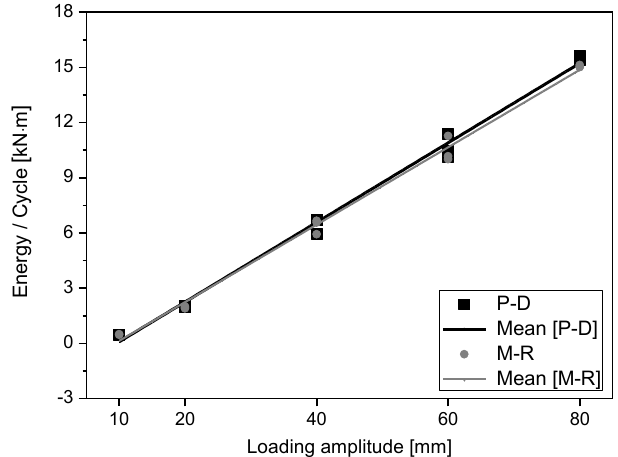
Figure 6. Energy line in each cycle for P–D and M–R.